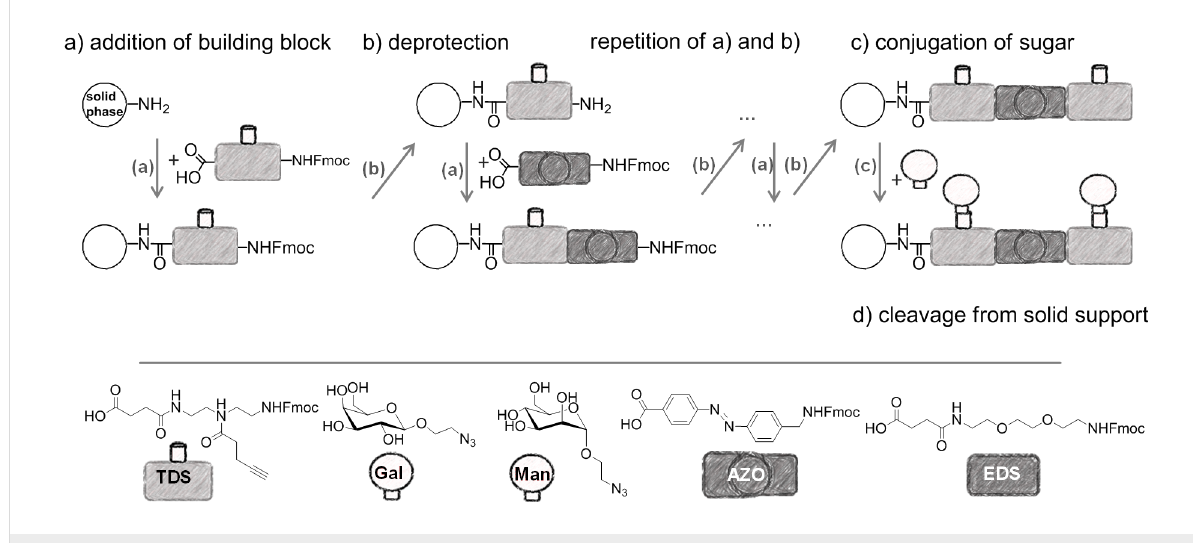
Figure 1: Synthesis of photoswitchable precision glycooligomers via stepwise addition of building blocks on solid support followed by on-resin func- tionalization of alkyne side chains with sugar azide ligands and final cleavage from the support.